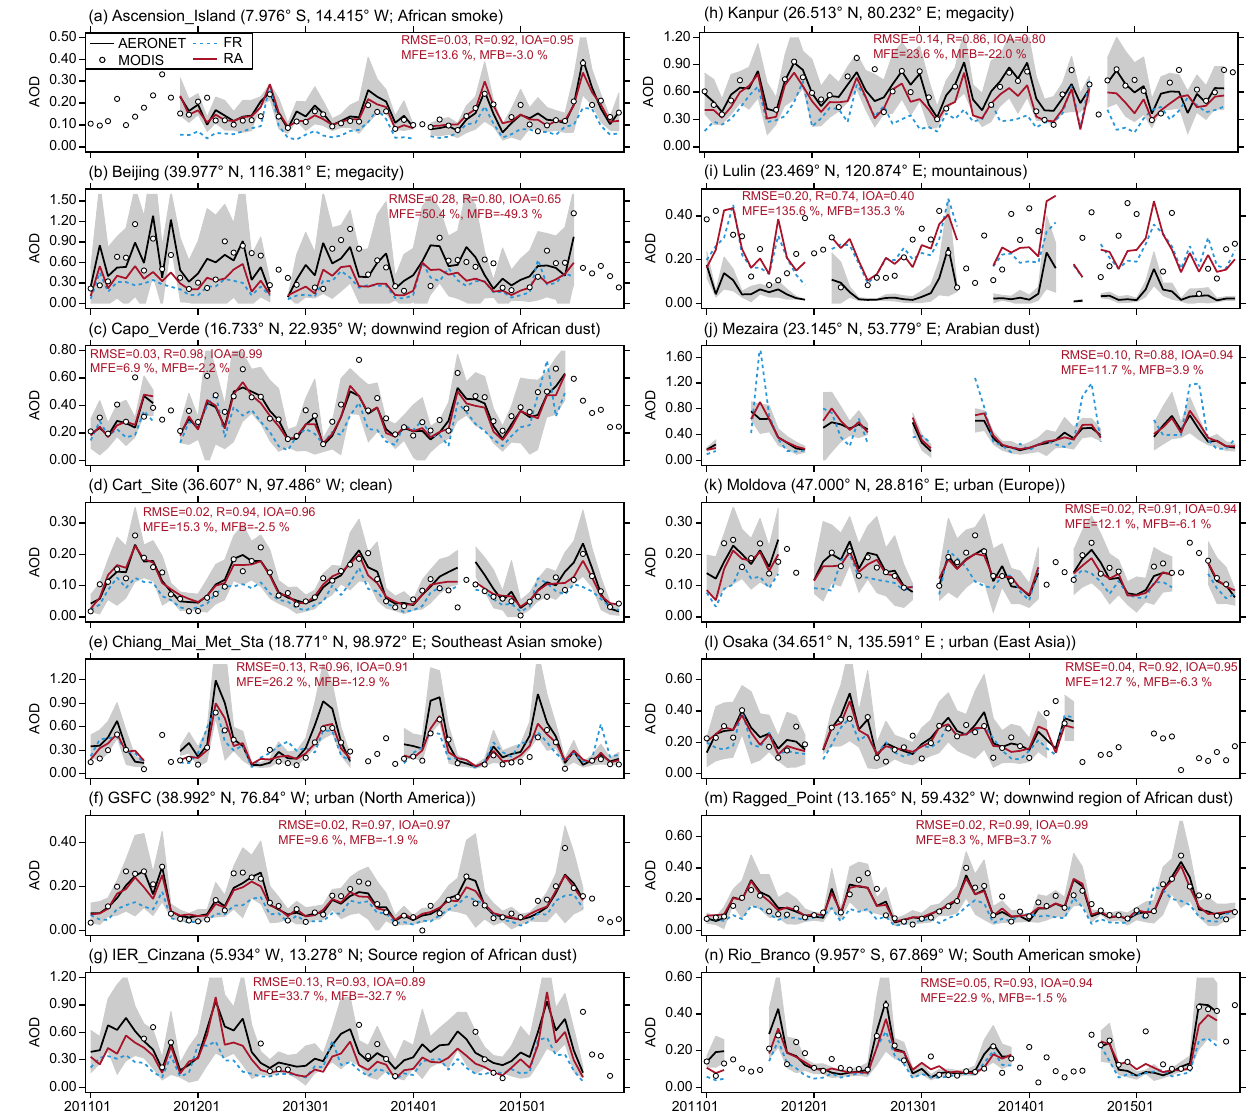
Figure 18. Time series of monthly averaged AERONET and modeled AODs. The AERONET, FR, and RA AODs are shown with black, blue, and red lines, respectively. Gray shading denotes standard deviations of the AERONET AODs. Monthly averages of NRL-UND MODIS AODs over each AERONET site are shown by circles. RMSE, R , MFE, MFB, and IOA values for RA are also shown. Locations of sites are shown by red circles in Fig. 3. Beijing, Capo_Verde, Cart_Site, Chiang_Mai_Met_Sta, GSFC, Kanpur, Moldova, Ragged_Point, and Rio_Branco are included among the sites selected for validation of the ICAP-MME (Sessions et al., 2015).